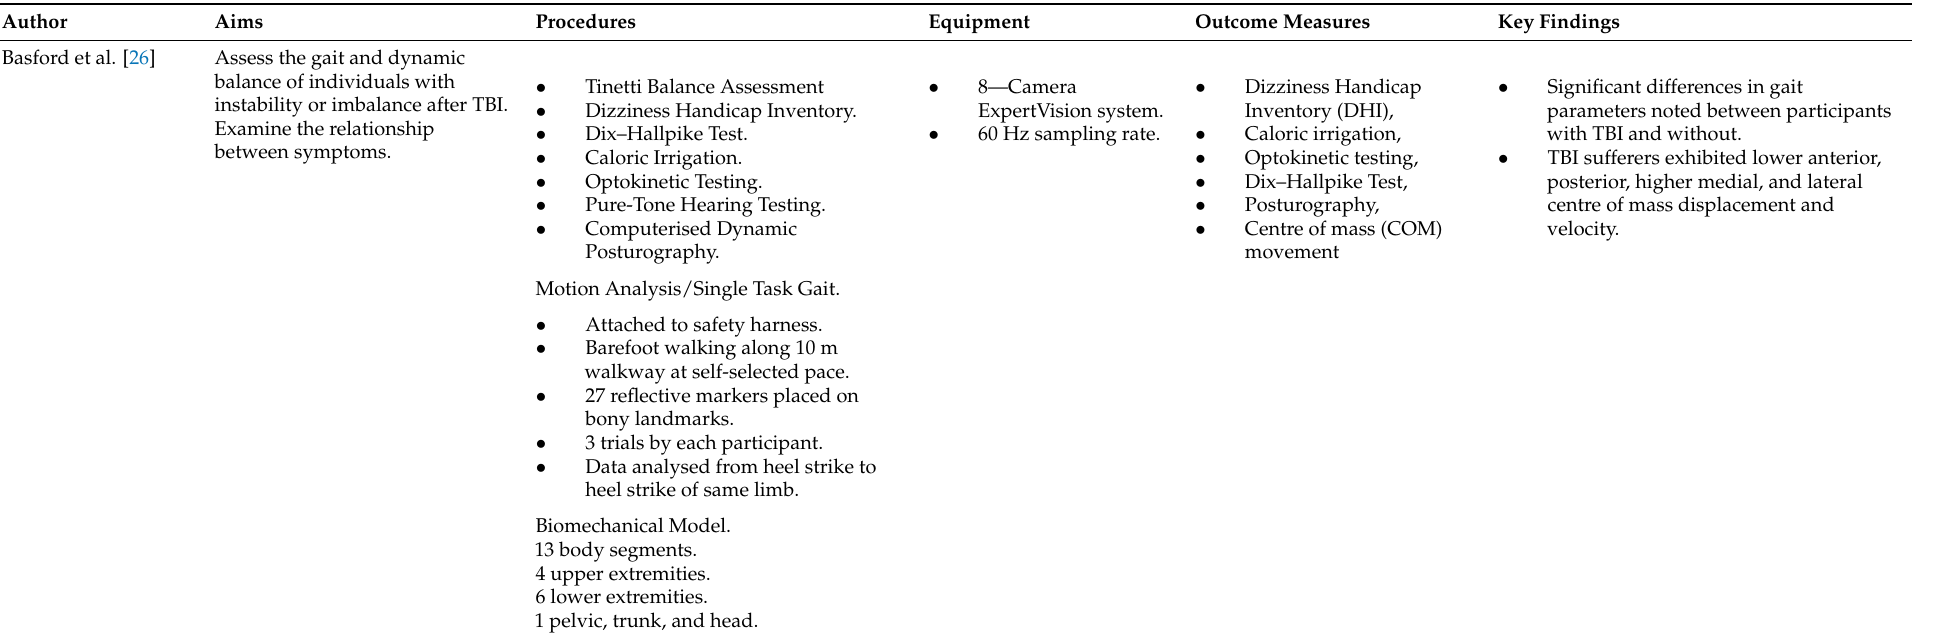
Table 2. Study aims, procedures, equipment, outcomes, and